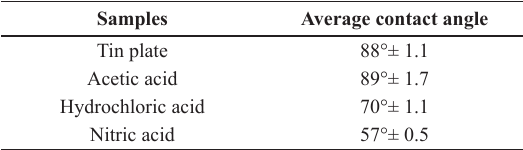
Table 1. Contact angle values obtained by the sessile drop method. Samples